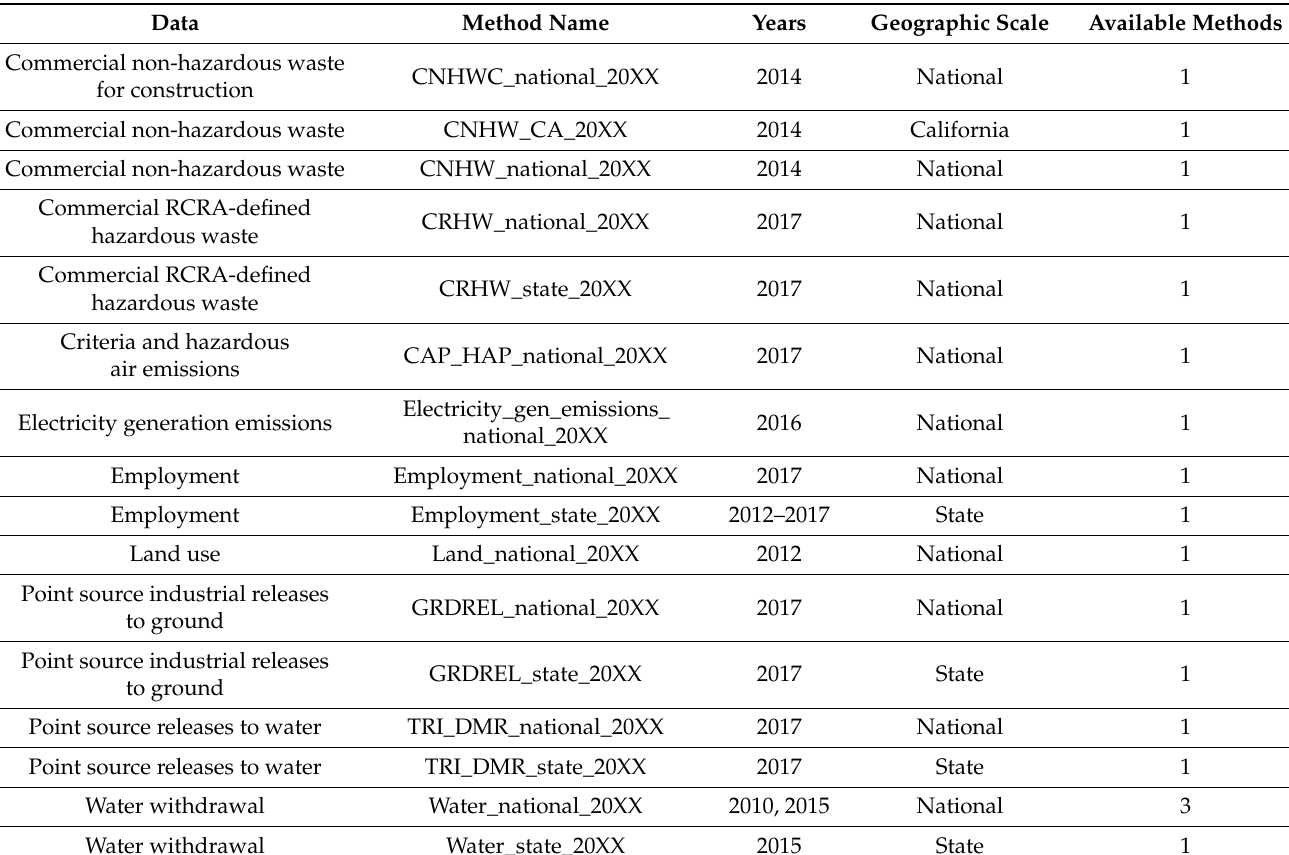
Table 4. Flow-By-Sector methods available in FLOWSA